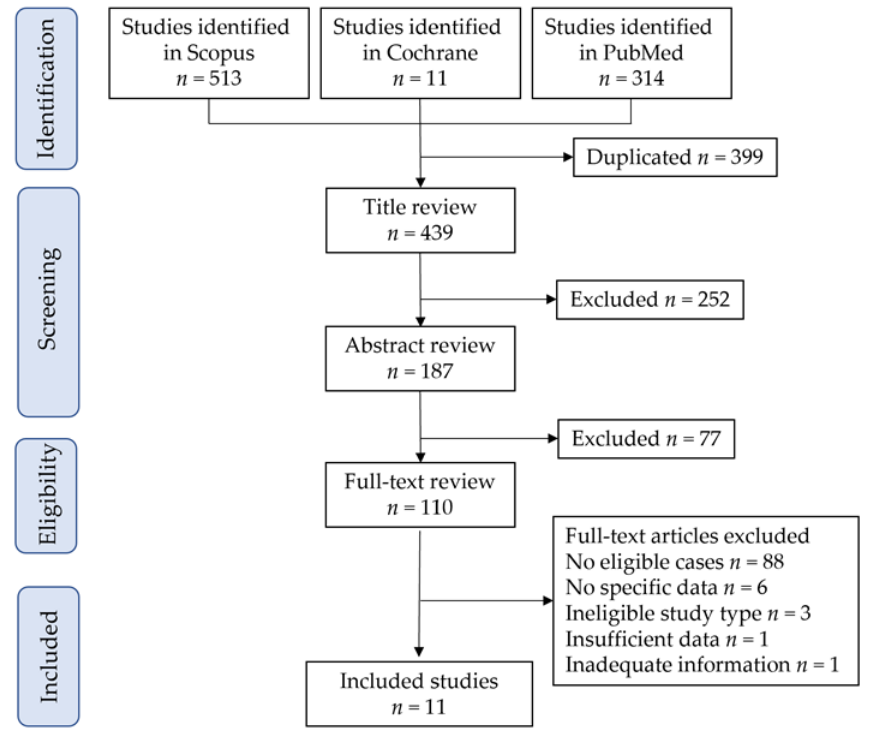
Figure 3. Study selection scheme of the systematic search of previous studies. Table 1. Summary of included